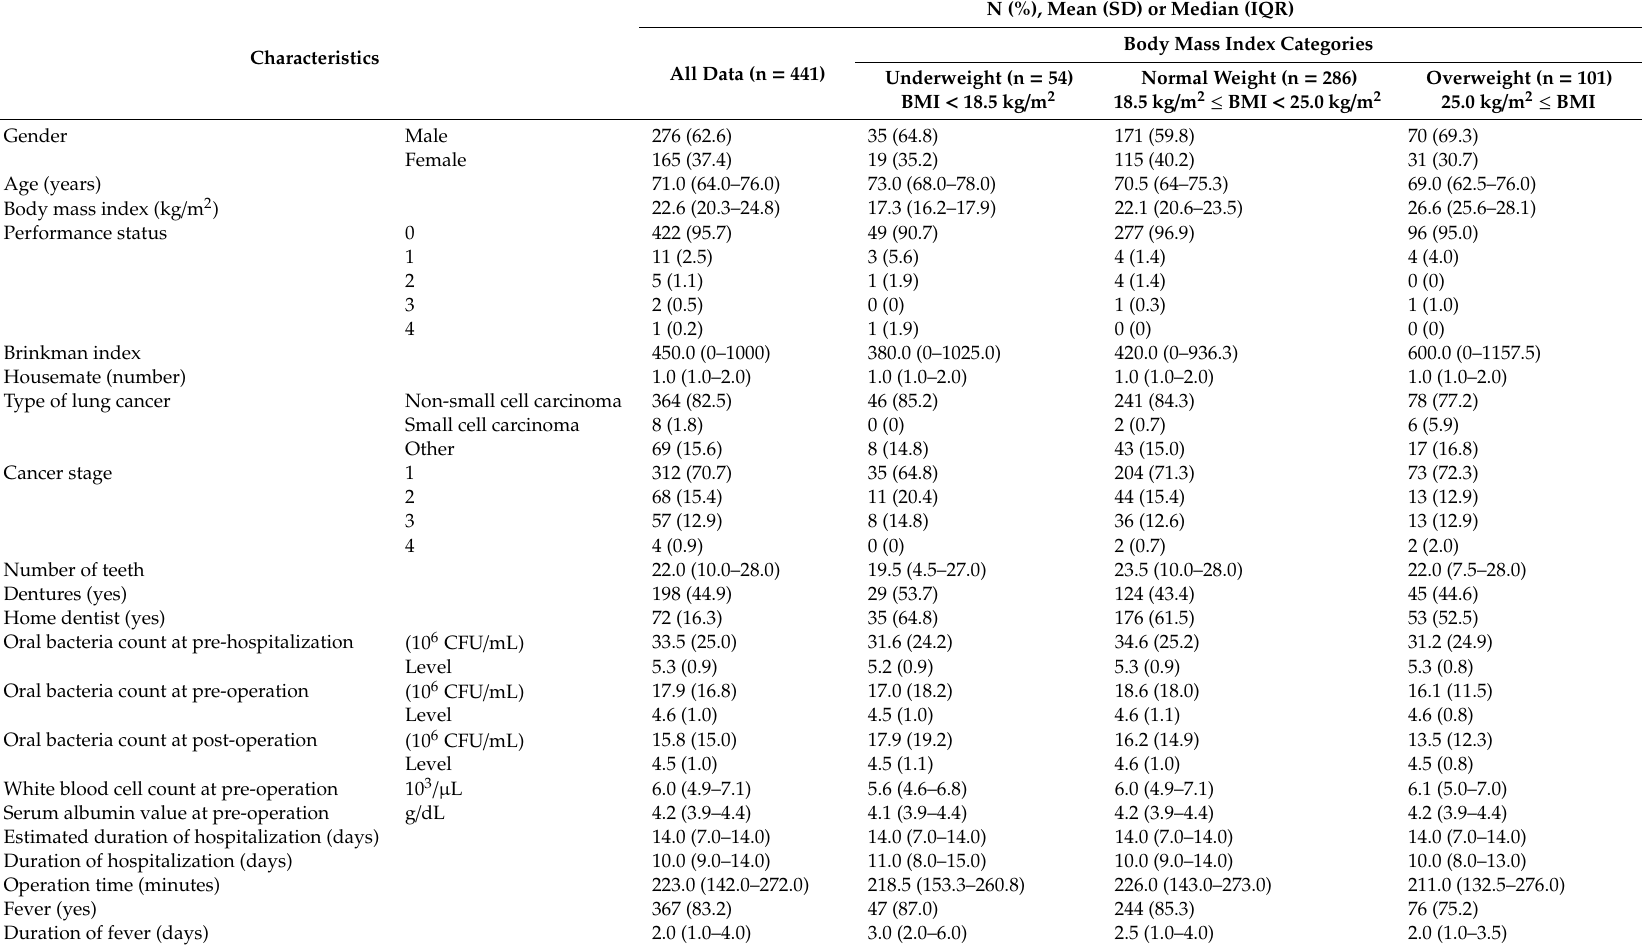
Table 1. Patient demographics and